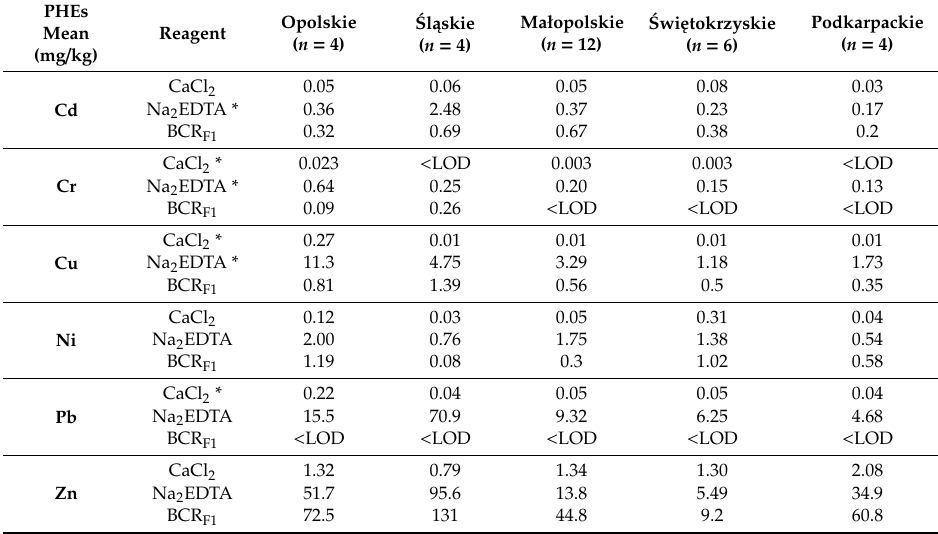
Table 2. Forms of PHEs that are bioavailable for plants in the agricultural soils in the Regions of southern